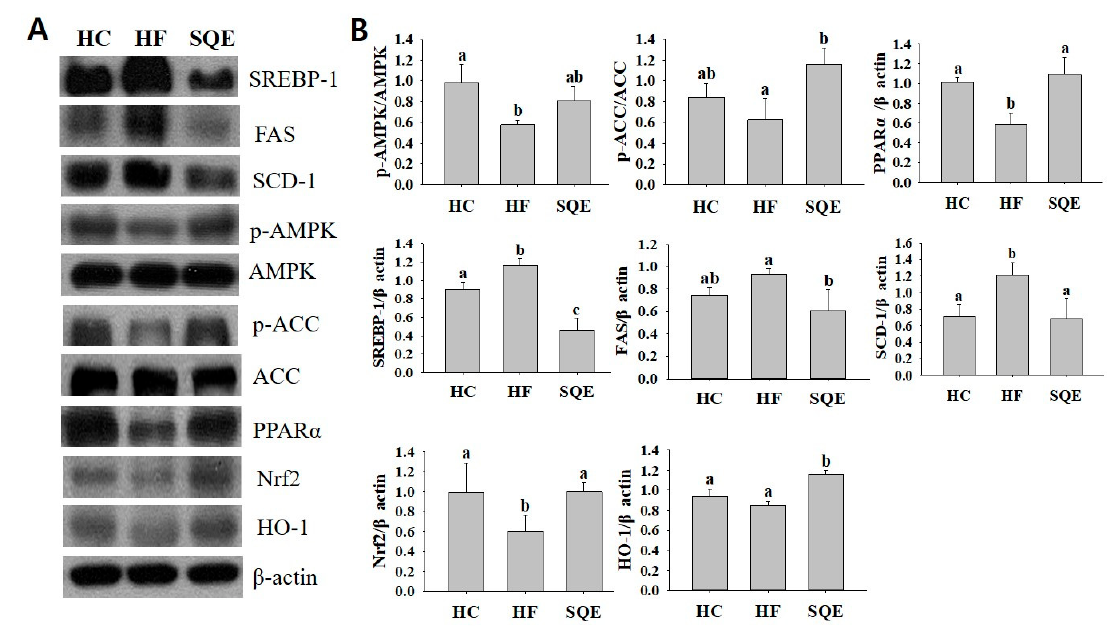
Figure 6. Effect of SQE on protein expressions in liver tissues of HF-diet-fed rats: ( A ) Protein levels were determined by Western blotting, and the data shown are representative of three experiments; ( B ) relative band intensity was determined by densitometry and normalized with β -actin. Results are expressed as the mean ± SD ( n = 4). Different letters in each assay indicate significant differences among the HC, HF, and SQE groups by Tukey’s multiple range test ( p < 0.05). HC, 46% carbohydrate diet; HF, 60% fructose diet; SQE, 60% fructose diet with SQE (500 mg/kg of BW) in drinking water. BW, body weight; HC, high-carbohydrate-diet-fed rats; HF, high-fructose-diet-fed rats; SQE, the high-fructose-diet-fed rats supplemented with S. quelpaertensis leaf extract. Table 2. Summary of sequencing read alignment to the reference